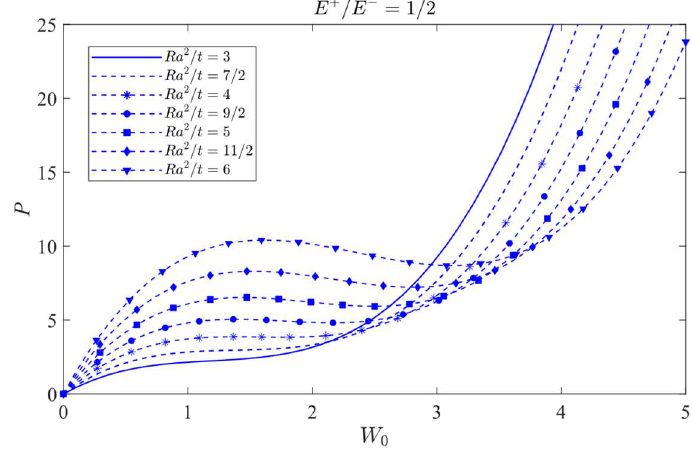
Figure 14. Load vs. central deflection when λ = 1/2 and E + / E − = 1/2.